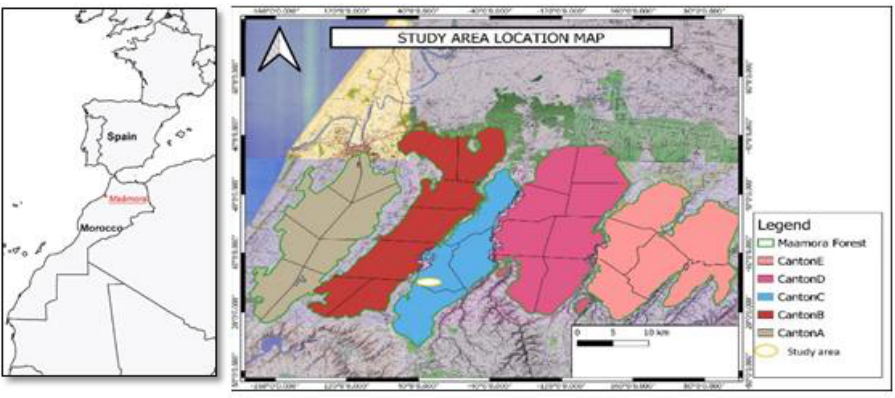
Figure 2. Location of Maamora forest.